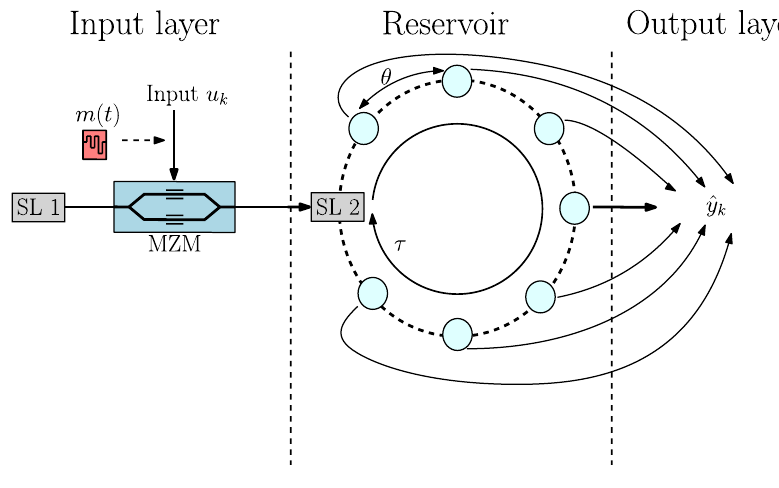
Figure 1: Illustration of a delay-based RC system using a semiconductor laser